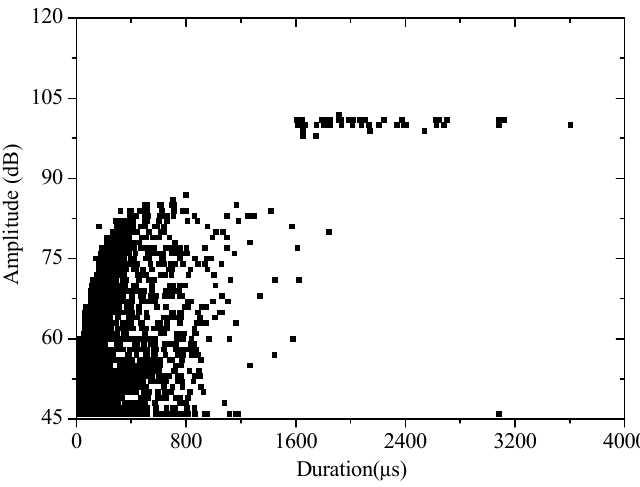
Figure 6. AE amplitude vs. duration (1.0 kg/m 3 ).